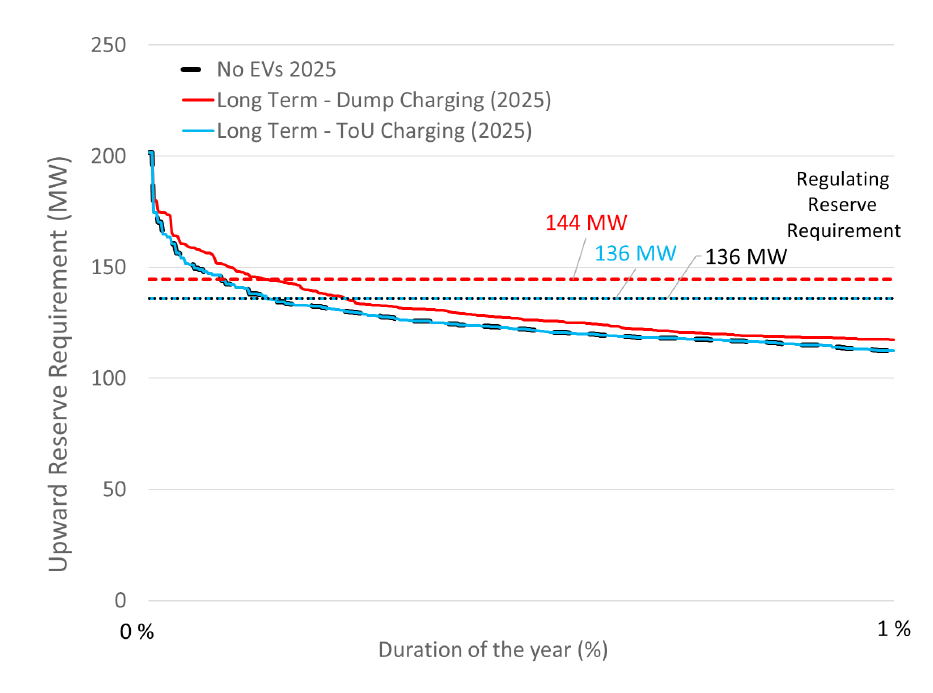
Figure 9: The largest 1% of upward variation of load in Long term scenario.